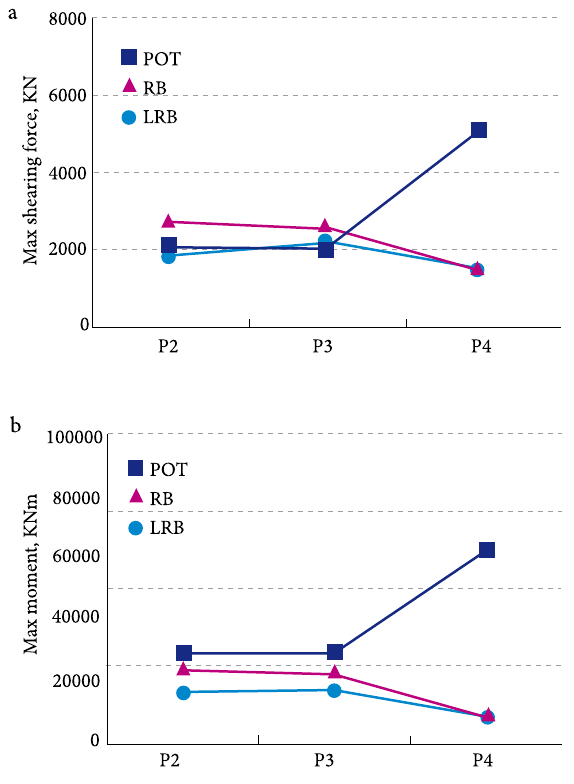
Fig. 8. Max shearing force (a) and max moment (b) in comparison of section force of each pier (non-linear time history